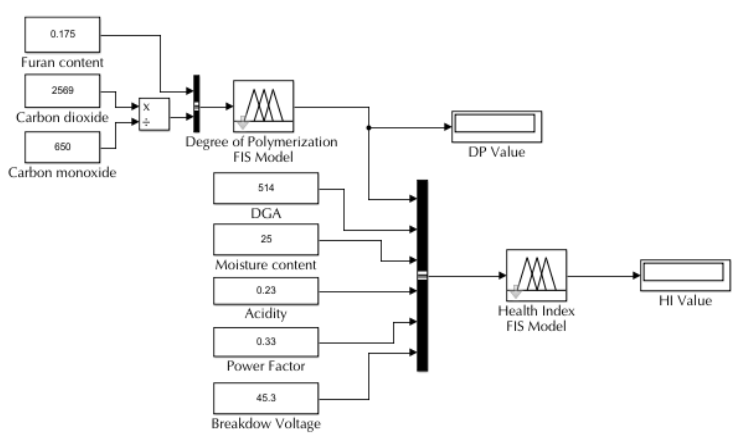
Figure 10. Health index fuzzy model.